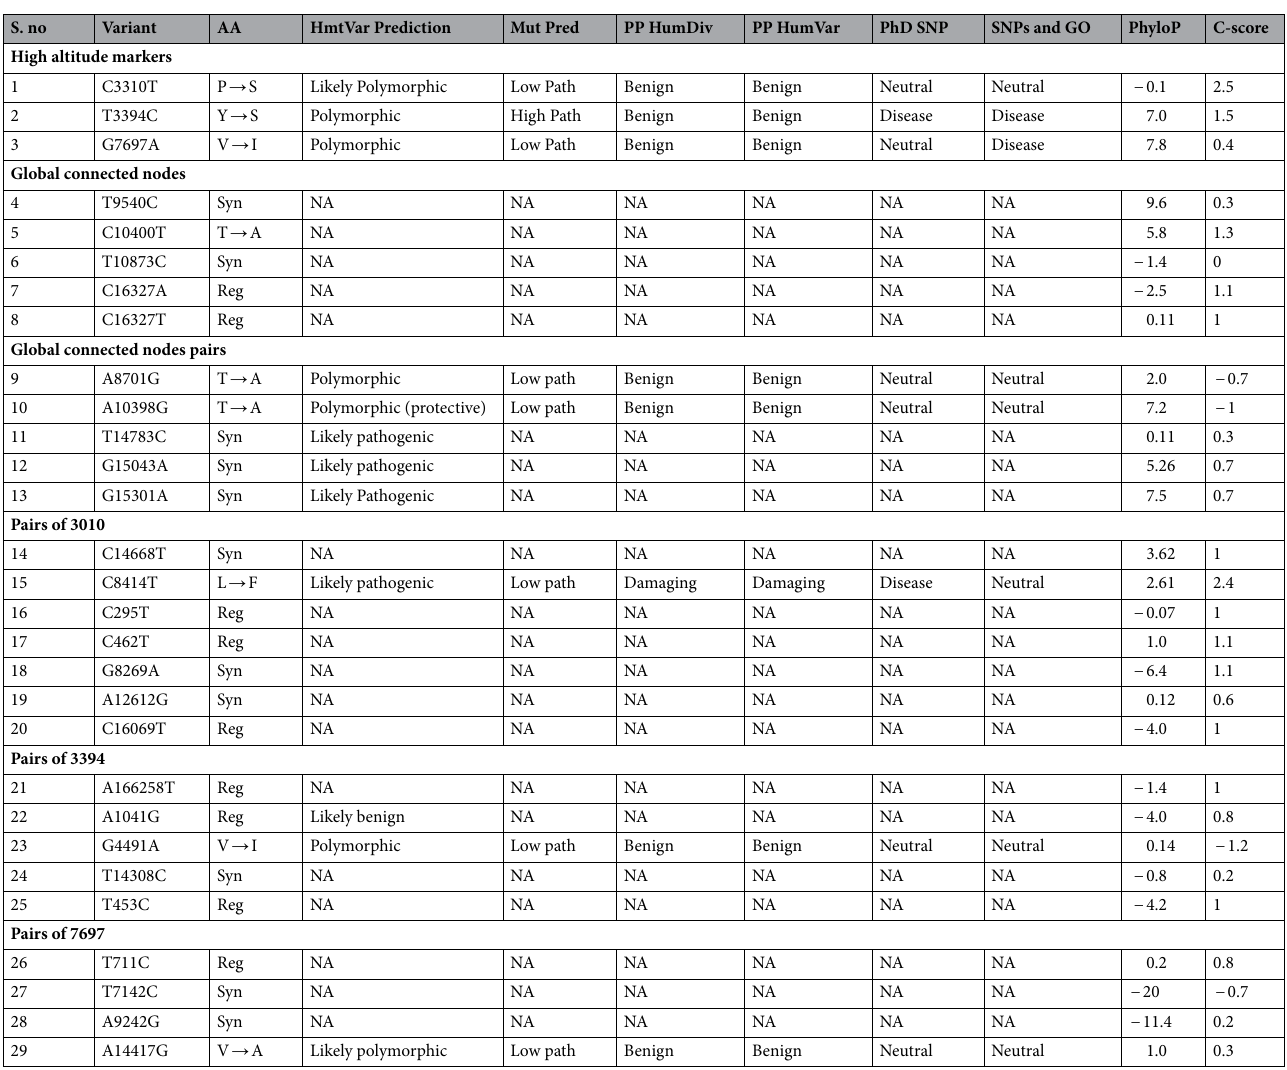
Table 6. HmtVar predictions and CADD scores for selected